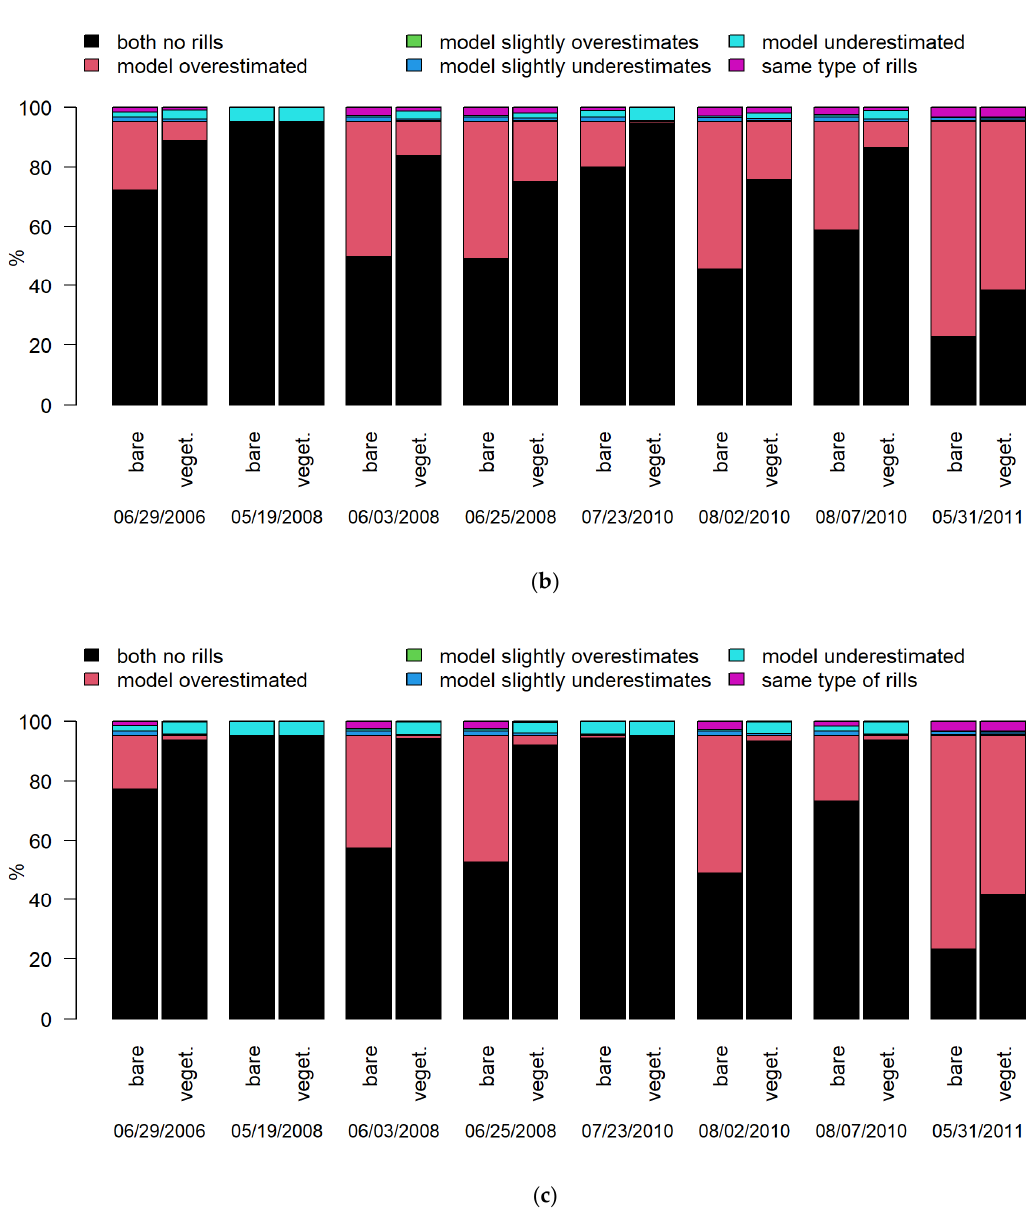
Figure 7. A comparison of the modelled rills and the measured rills for the ( a ) MEAN − STD, ( b ) MEAN, ( c ) MEAN + STD model parameters scenario.